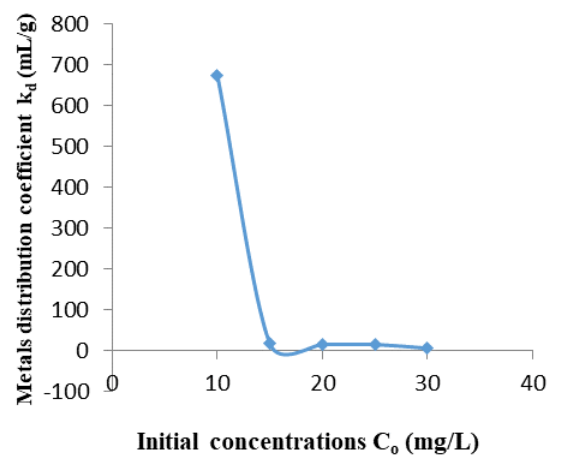
Fig. 12 . Effect of initial concentration on the K d of Cd 2+ ions onto